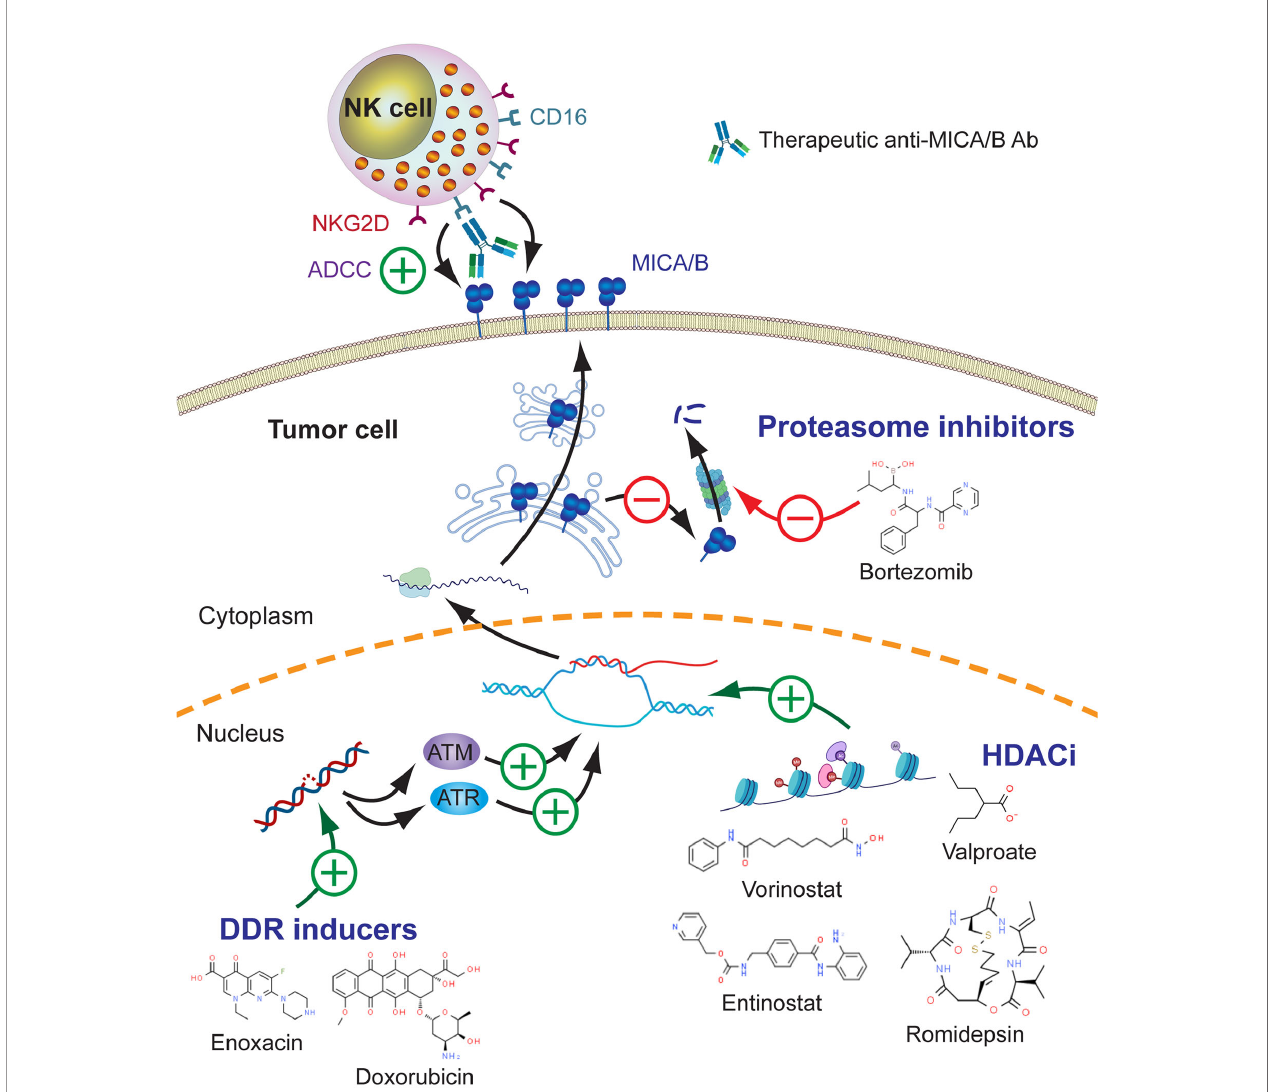
FIGURE 3 | Leveraging anti-MICA/B Ab therapeutic ef fi cacy through combination therapies with DDR inducers, HDACi and proteasome inhibitors. The use of DDR inducers, HDACi and proteasome inhibitors may lead to an increased MICA/B synthesis, reduced degradation, and its consequent accumulation on the cell surface. This effect may result in an improved CD16-dependent ADCC of anti-MICA/B Ab, and a recovery of NKG2D-dependent NK cell-mediated cytotoxicity against tumor cells, facilitating the reinstatement of an ef fi cient tumor cell